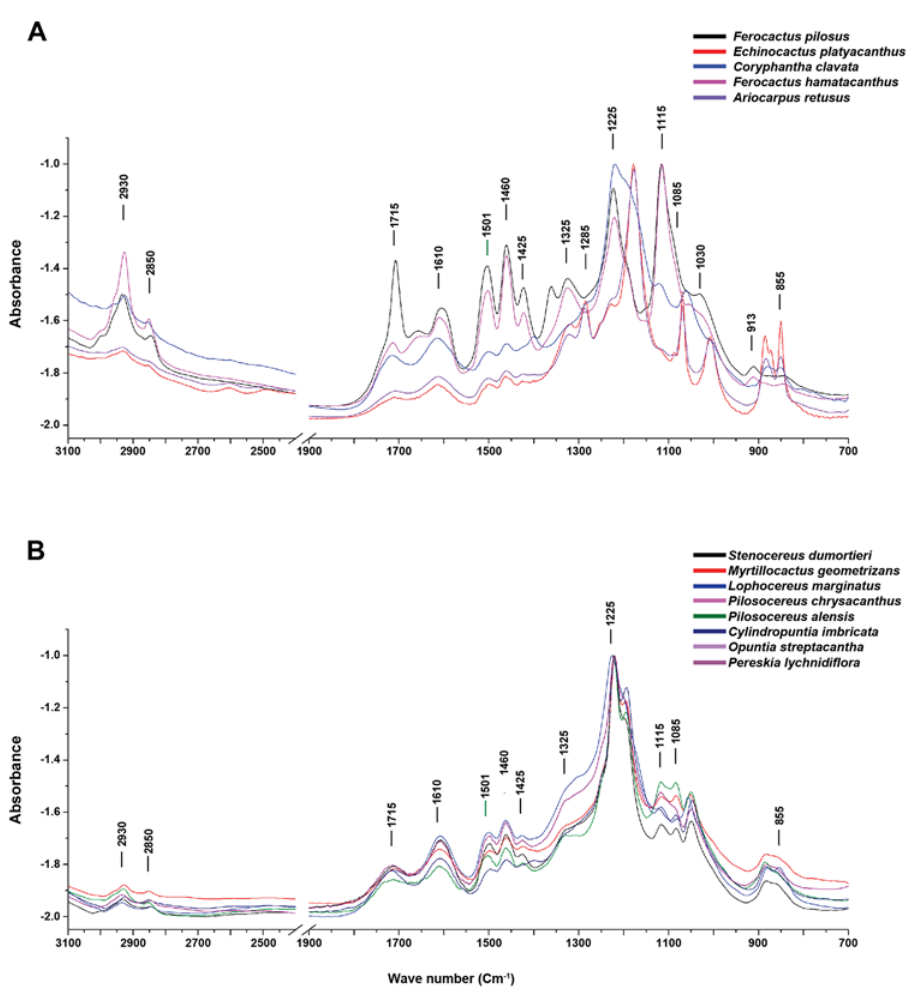
belonging from the early derived taxa to the more derived ones showing a highly conserved lignin spectra pattern. (S2 Dataset shows FTIR spectra